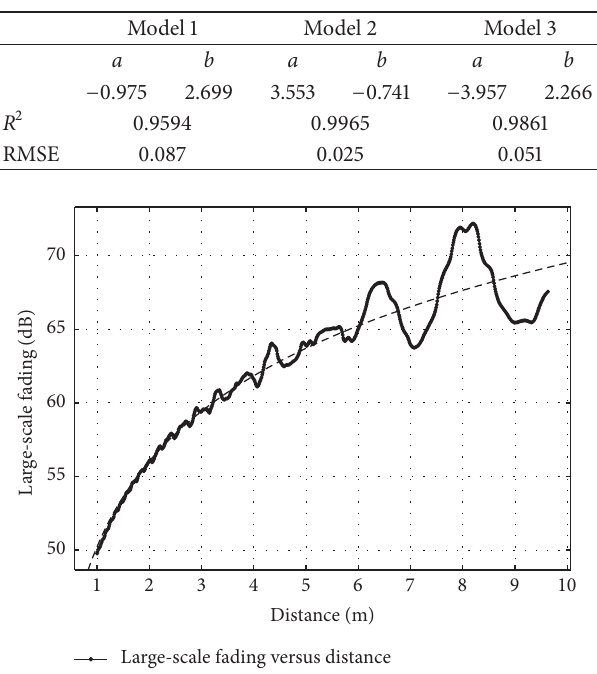
Table 4: Parameters of three models.